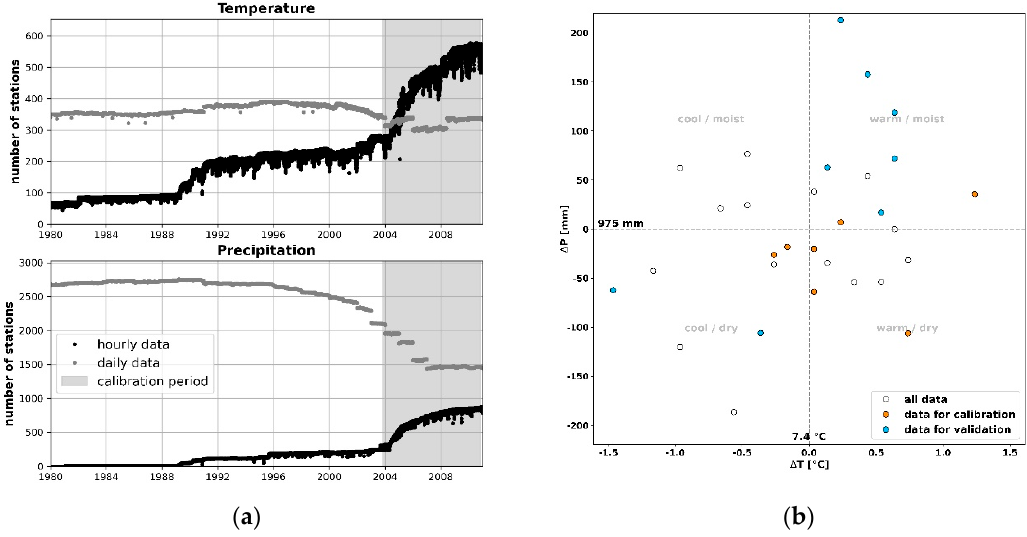
Figure 3. Selection of a calibration period based on meteorological data. ( a ) Number of stations available for spatial interpolation and temporal disaggregation for air temperature and precipitation. Black dots represent stations with hourly records, gray dots represent daily measurements. ( b ) Spatially averaged annual precipitation and temperature anomalies w.r.t 1981–2010 for the Hydrological Bavaria. Orange dots represent years selected for calibration.